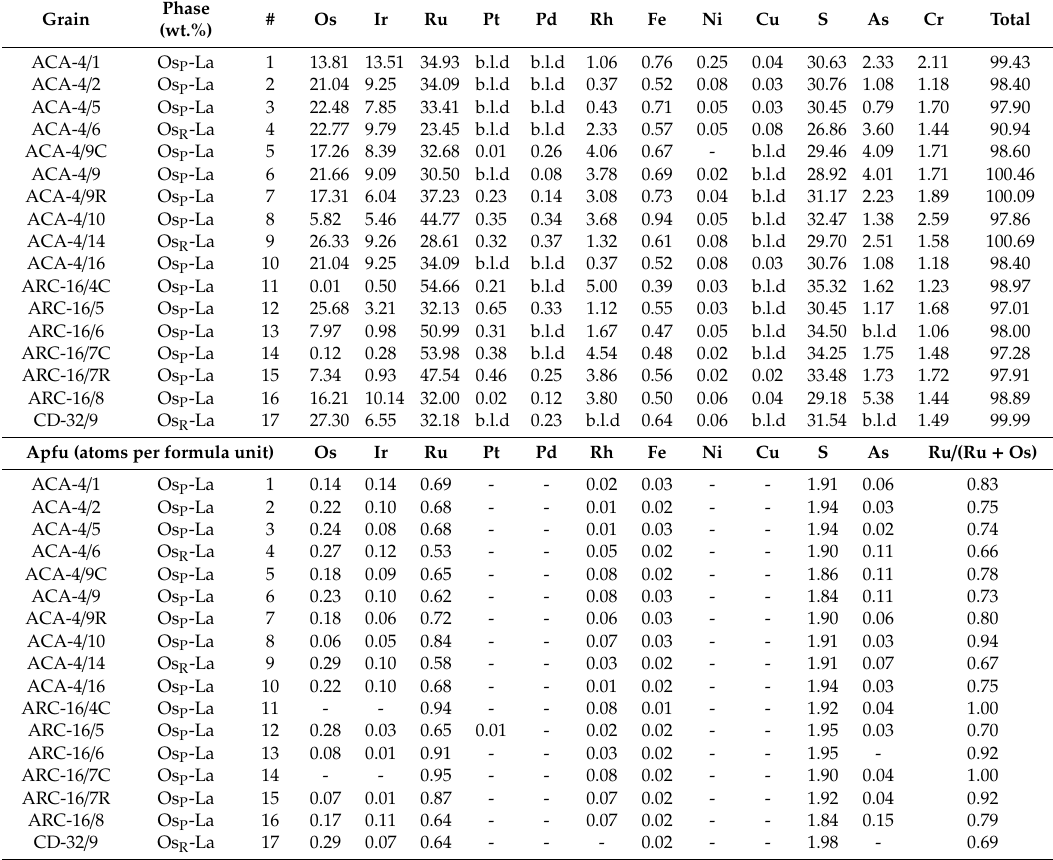
Figure 3. Ru-Os-Ir plots of the laurite grains from the investigated chromitites and from those studied by [21] (shaded domains). From left to right: ( a ) plot of a grain with normal zoning with little chemical variation between core (C) and rim (R); ( b ) plot of one grain with normal zoning with remarkable chemical variation (C: cores, R: rims, arrows indicate compositional variation from cores to rims); ( c ) plot of laurite grains displaying oscillatory zoning) and ( d ) plot of laurites without zoning. Table 1. Representative EPMA analyses of minerals from the laurite-erlichmanite series. Grain